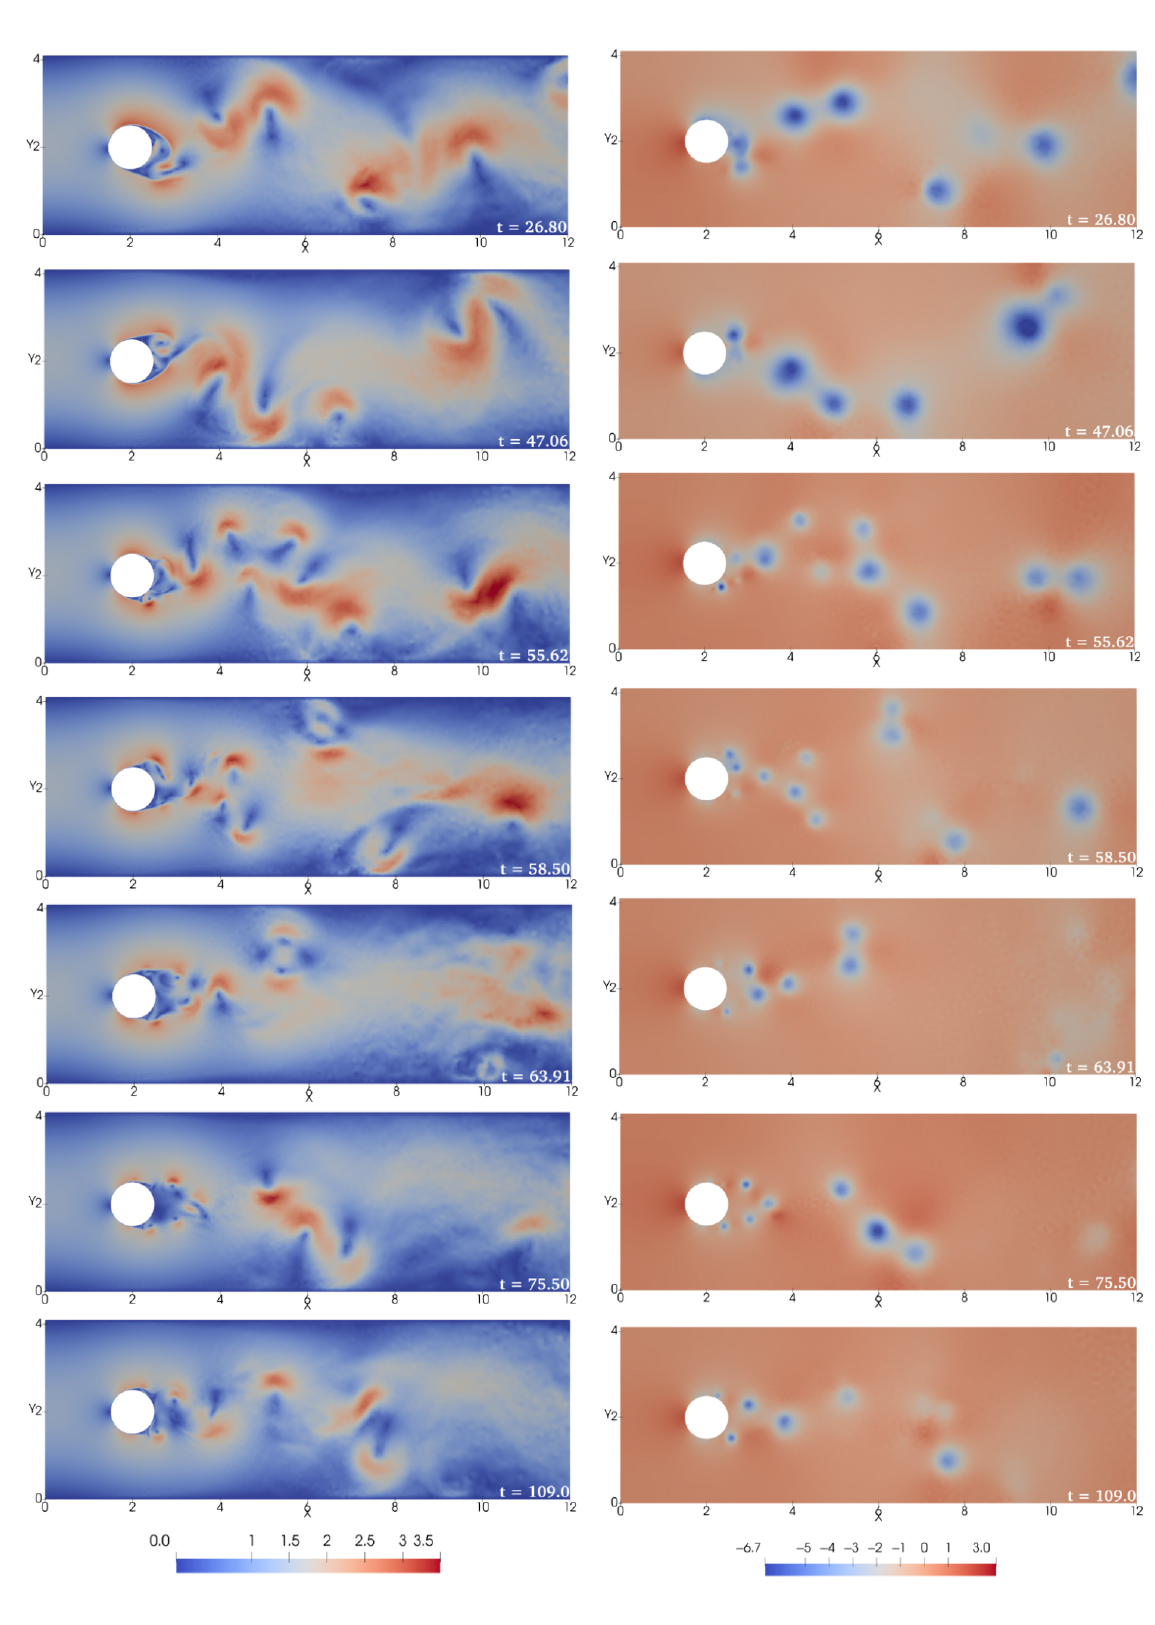
Figure 16. Magnitude of the velocity ( left ) and pressure ( right ) field progression at Re = 2000. The control starts at t = 50, therefore the first two panels of each column correspond to the uncon- trolled case and the rest (involving smaller vortices) correspond to the controlled